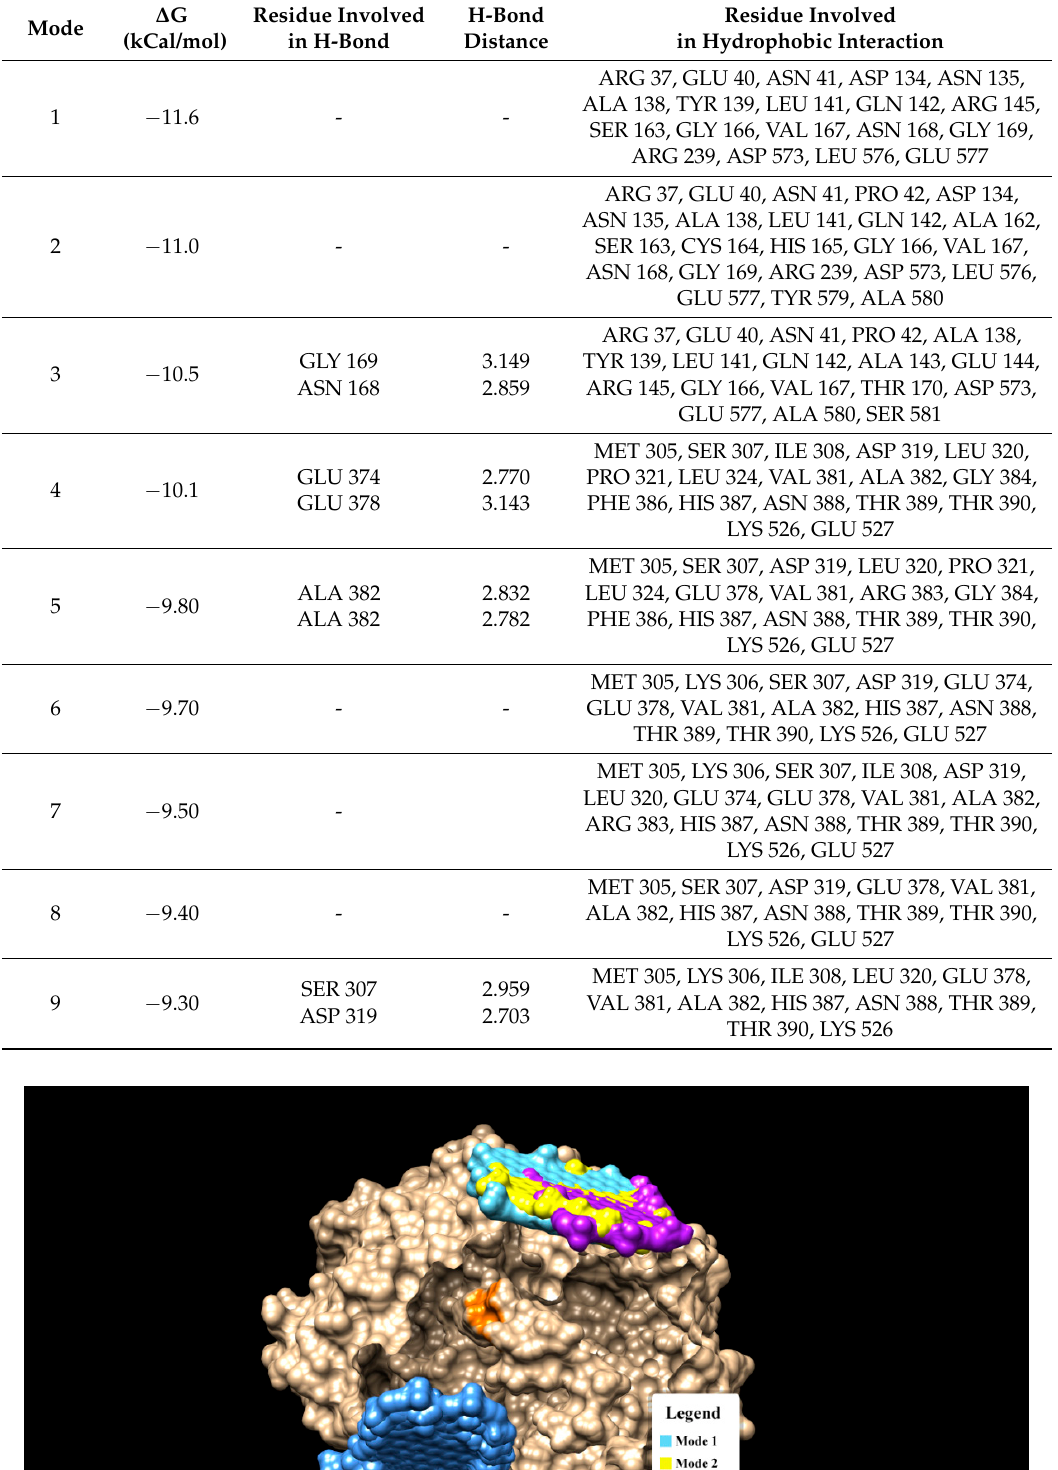
Table 1. The docking results of GOx-Graphene.